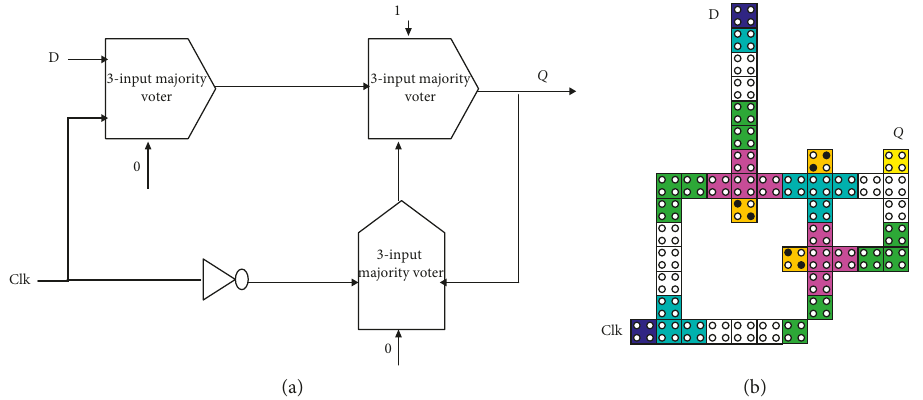
Figure 10: Proposed (a) logical diagram and (b) QCA layout of D flip-flop.